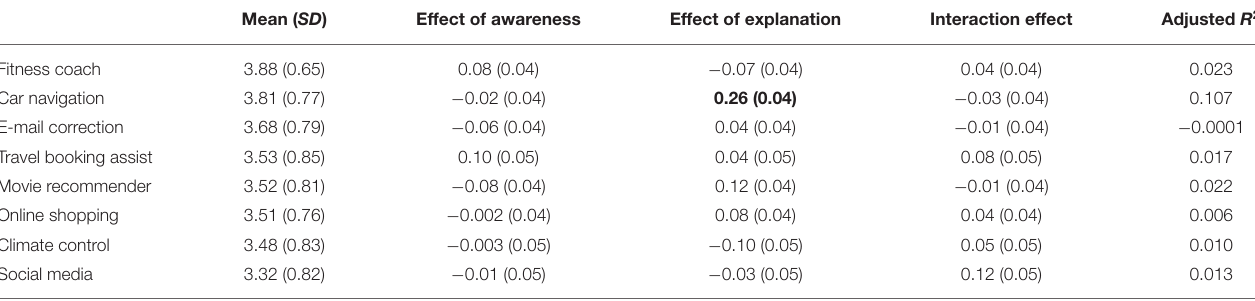
TABLE 6 | The means and standard deviations of perceived autonomy and the modeling results (regression coefficients with standard errors and adjusted R 2 ) for each of the eight application scenarios (ranked from high to low in terms of perceived autonomy).